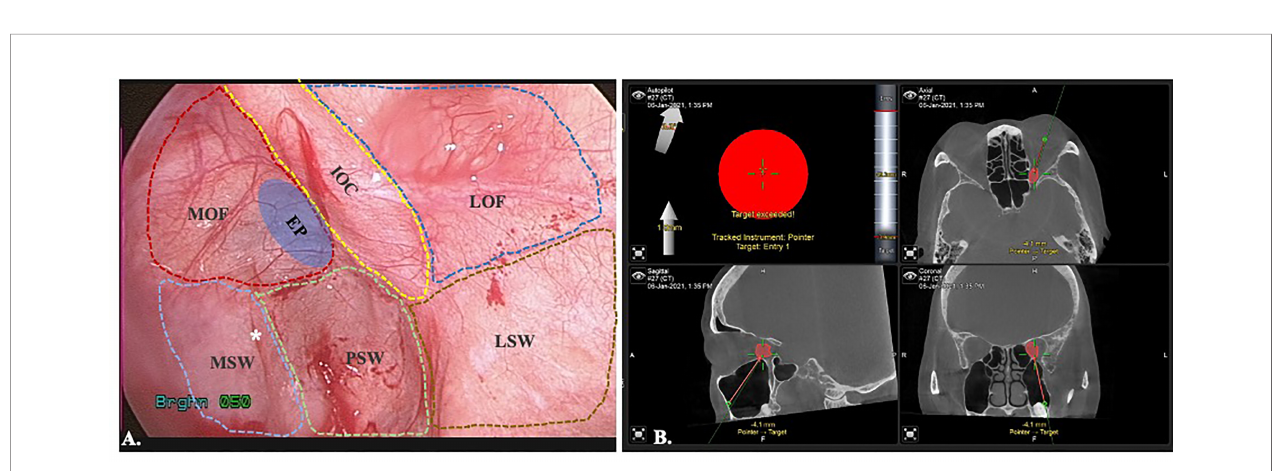
FIGURE 3 | Endoscopic view of transmaxillary approach with the trajectorial-guided entry to the orbit. (A) . MOF, medial orbital fl oor; IOC, infraorbital canal; LOF, lateral orbital fl oor; MSW, medial sinus wall; PSW, posterior sinus wall; LSW, lateral sinus wall; EP, entry point; *maxillary ostium. (B) Trajectorial-guided orbital